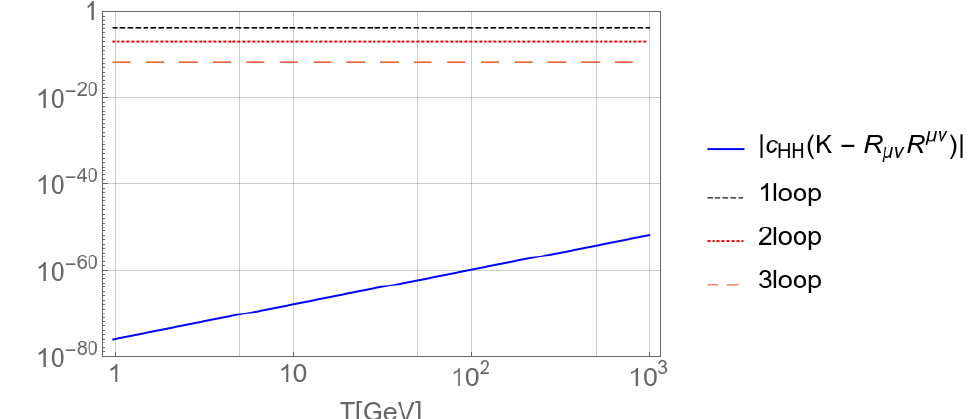
(cid:21) 2 HX K(cid:0) R (cid:22)(cid:23) R (cid:22)(cid:23) j , T is (4 (cid:25) ) 2 720 m 4 X n +1 . For the plot we chose H (16 (cid:25) 2 ) n